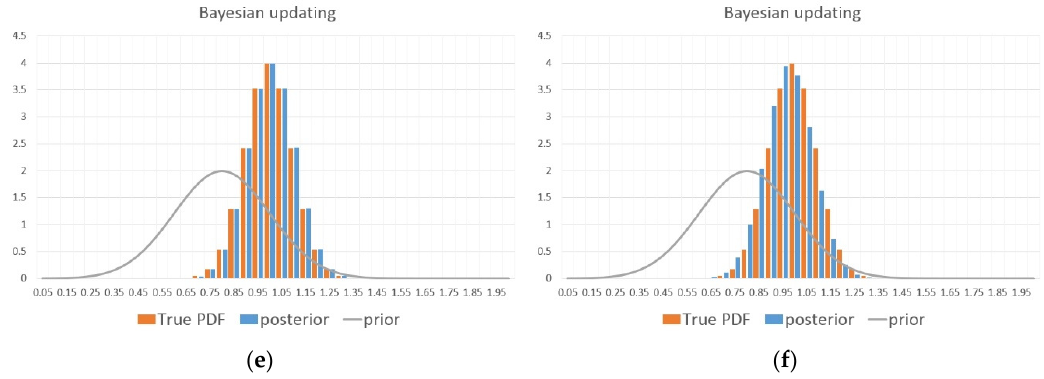
Figure 8. Bayesian updating at the stochastic field of the correlation distance d = 1.0: ( a ) How to perform Bayesian updating; ( b ) Observation point 1; ( c ) Observation point 2; ( d ) Observation point 3; ( e ) Observation point 4; ( f ) Observation point 5.